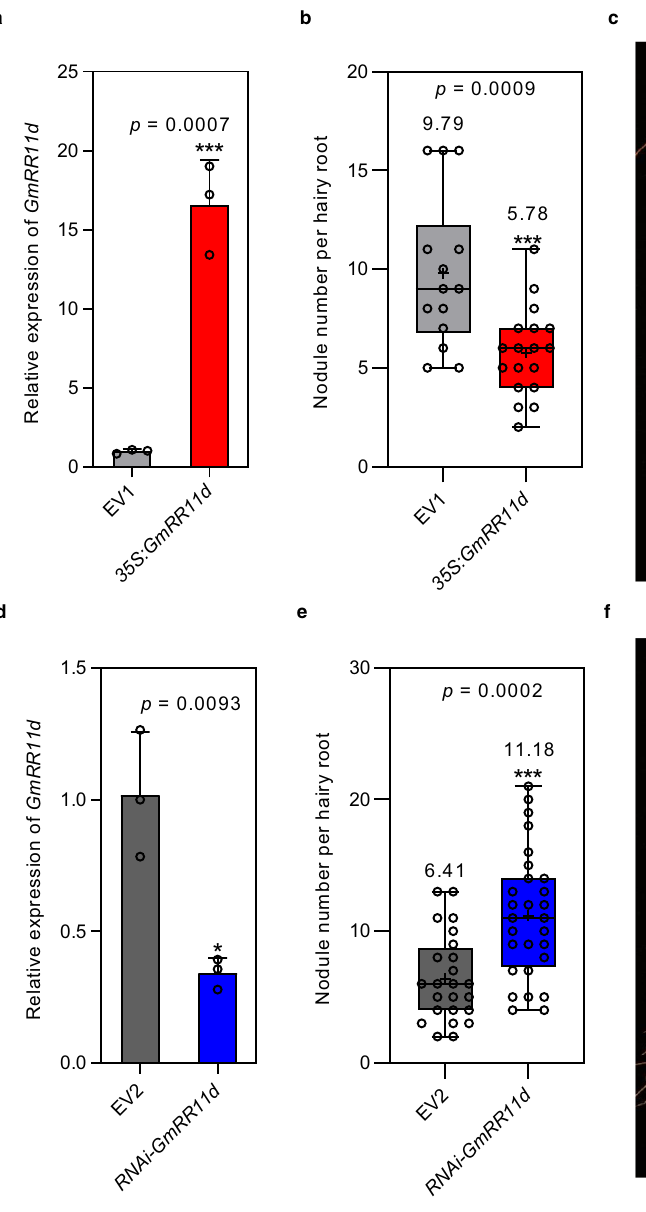
normalized against the geometric mean of soybean GmELF1b . Data are presented as means±SD from three biological replicates. Asterisks indicate signi fi cant dif- ferences relative to the EV2 control. Two-sided Student ’ s t -test, * p <0.05. e , f Nodulation phenotypic analysis of individual hairy roots expressing EV2 and RNAi-GmRR11d at 21 DAI. Scale bars=1cm. Data are presented as means±SD (24 hairy roots in EV2 and 28 hairy roots in RNAi-GmRR11d ). Three independent experiments were repeated with similar results. Asterisks indicate signi fi cant dif- ferences relative to the EV2control.Two-sidedStudent ’ s t -test, *** p <0.001. Boxes indicate the fi rst and third quartiles and the whiskers indicate the minimum and maximum values, the black lines within the boxes indicate the median values and black circles mark the individual measurements. The numbers above the boxes in ( b ) and ( e ) represent the mean